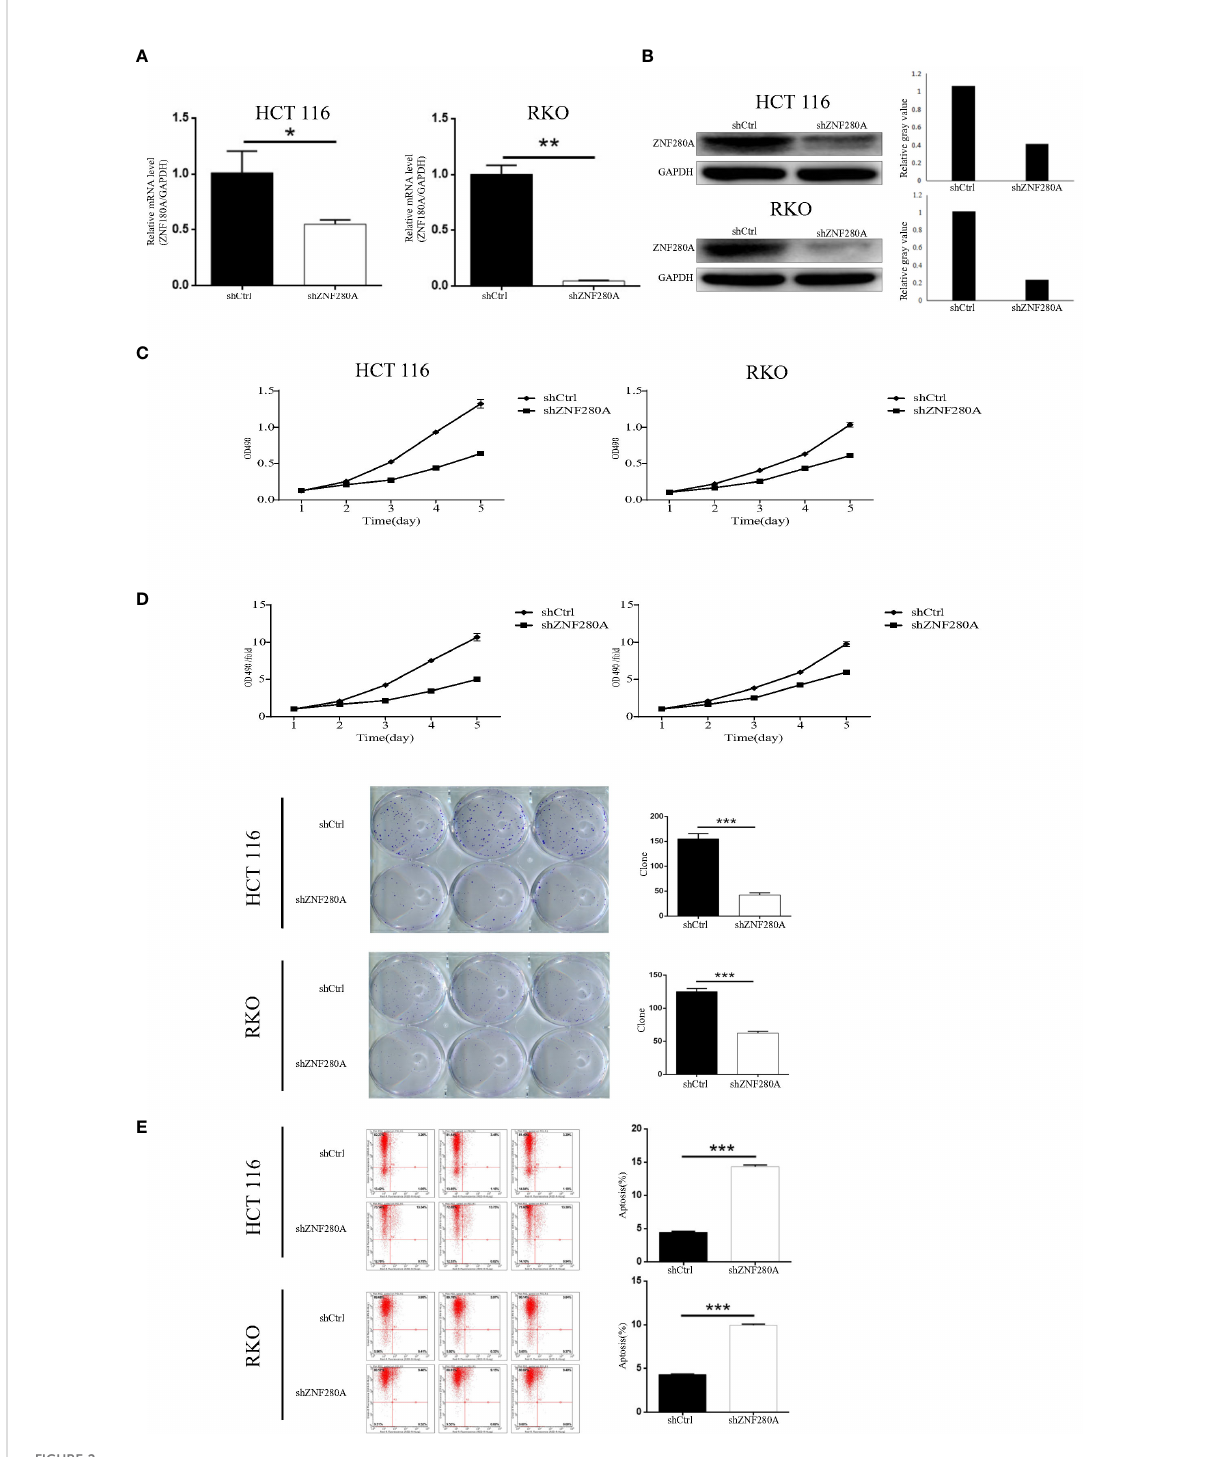
FIGURE 2 ZNF280A knockdown inhibits CRC progression in vitro. (A, B) Real-time PCR (A) and western blotting (B) analyses of ZNF280A expression in the indicated CRC cells. GAPDH was used as endogenous control in western blot. (C) MTT assay revealed that knockdown of ZNF280A suppressed the proliferation of HCT-116 and RKO cells. (D) Colony formation assay showed that knockdown of ZNF280A inhibited the colony-forming ability of HCT-116 and RKO cells. (E) Apoptosis of HCT-116 and RKO cells with or without ZNF280A knockdown were determined by fl ow cytometry. Data were shown as mean ± SD. *P<0.05, **P<0.01,